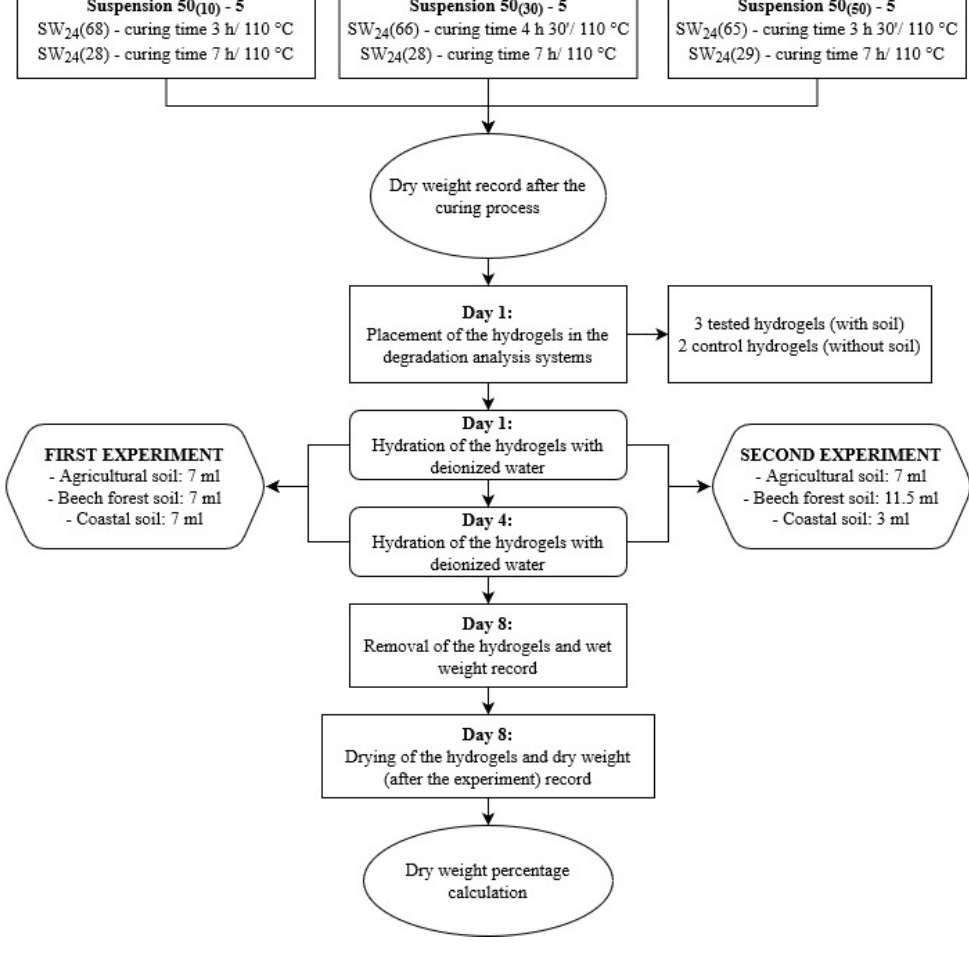
Figure 4. Degradation analysis experiments scheme.